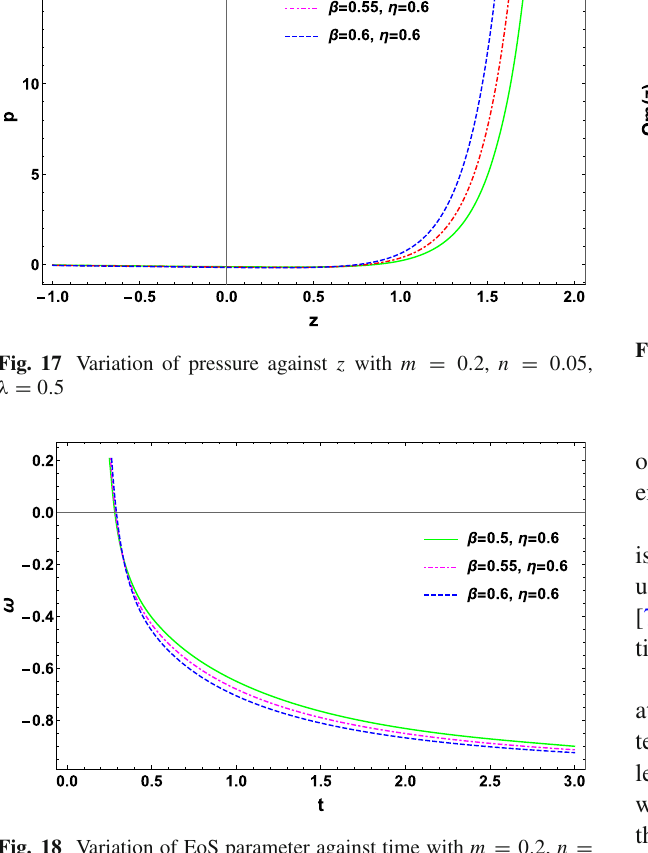
Fig. 18 Variation of EoS parameter against time with m = 0 . 2, n = 0 . 05, λ = 0 . 5